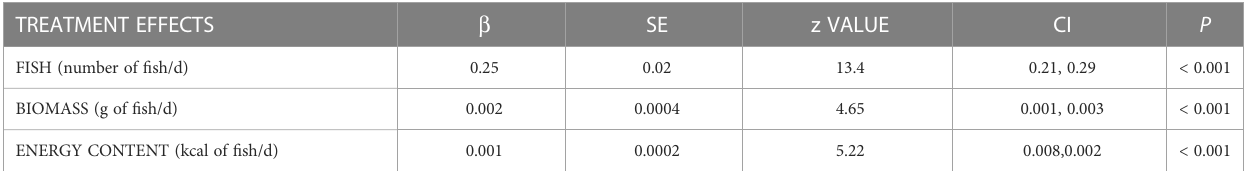
TABLE 3 Results of GLMMs with treatment effects on provisioning rates per d of nests under trail camera surveillance (N = 11) during the 2021 osprey breeding season in the lower Chesapeake Bay, VA, USA. TREATMENT EFFECTS